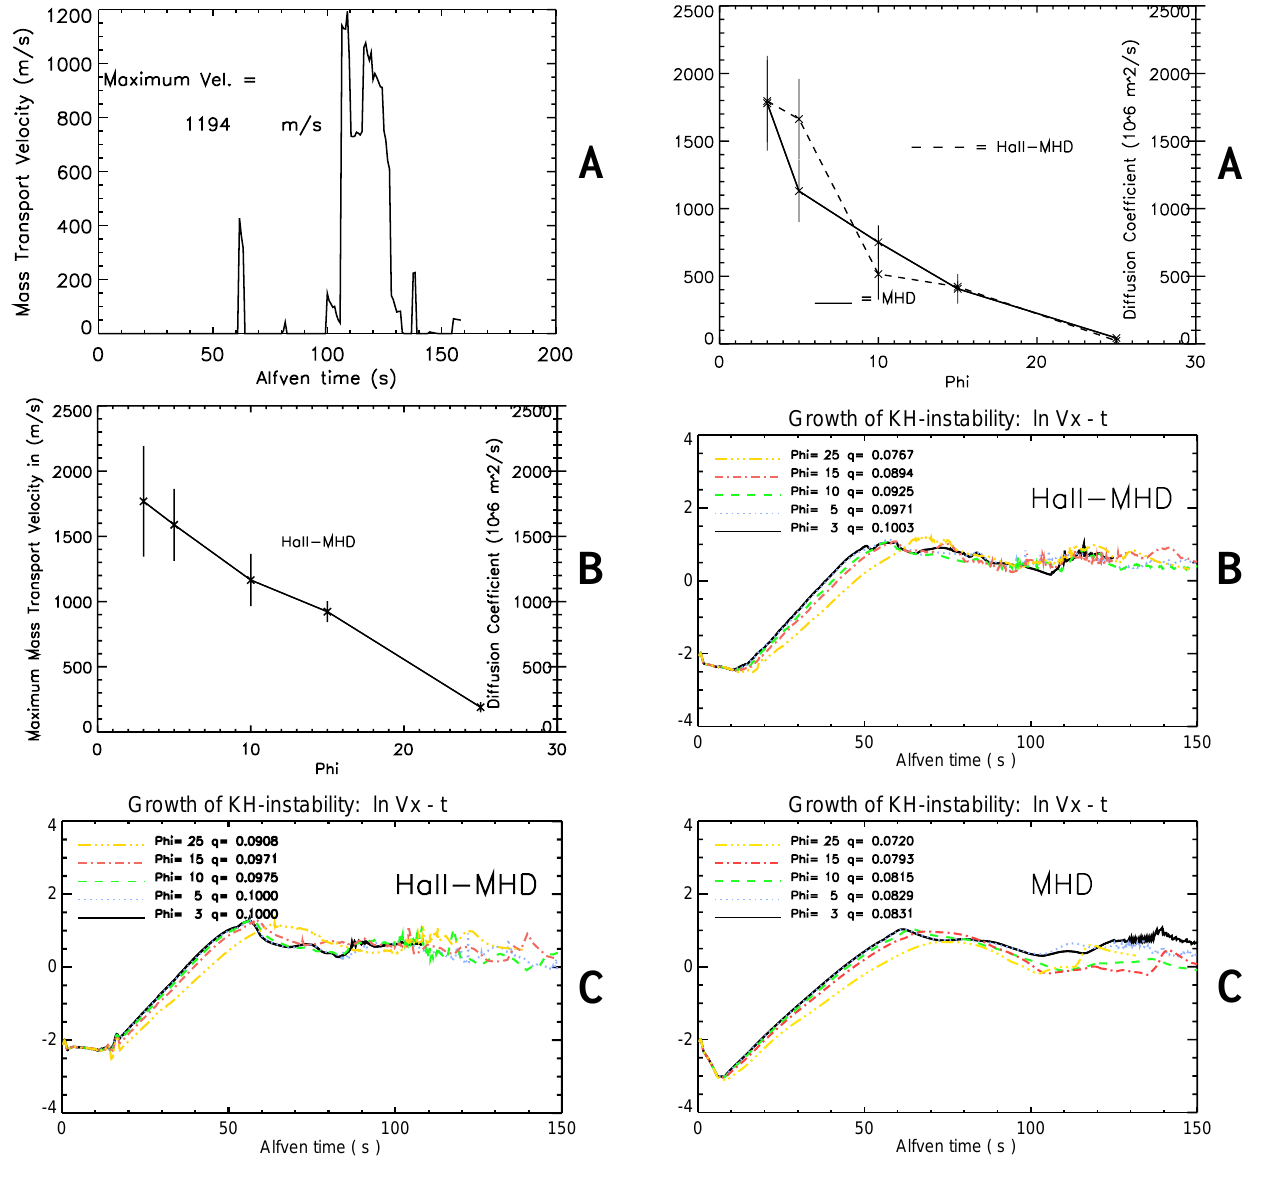
Fig. 7. (A) Mass transport velocity as a function of time for ϕ = 10 ◦ . (B) Mass transport velocity as a function of ϕ . (C) Growth of KH instability for ϕ = 3 ◦ , 5 ◦ , 10 ◦ , 15 ◦ and 25 ◦ .